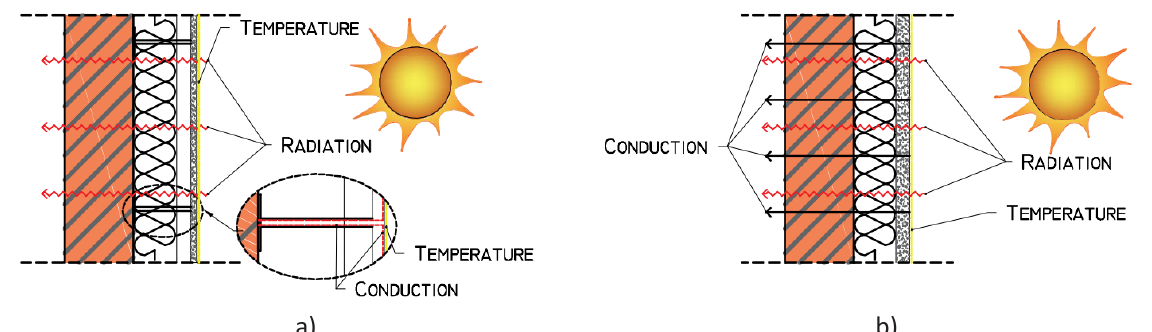
Figure 4: Heat transfer in a) ventilated facade; b) ETICS